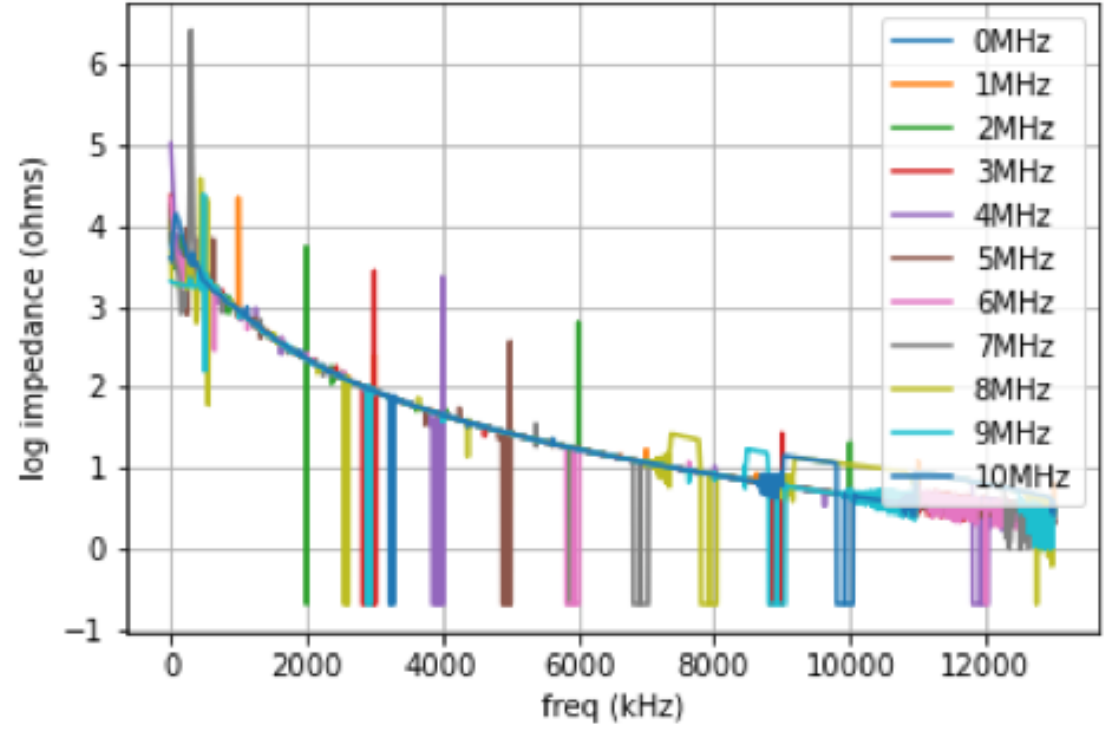
Figure A1. See text for discussion.